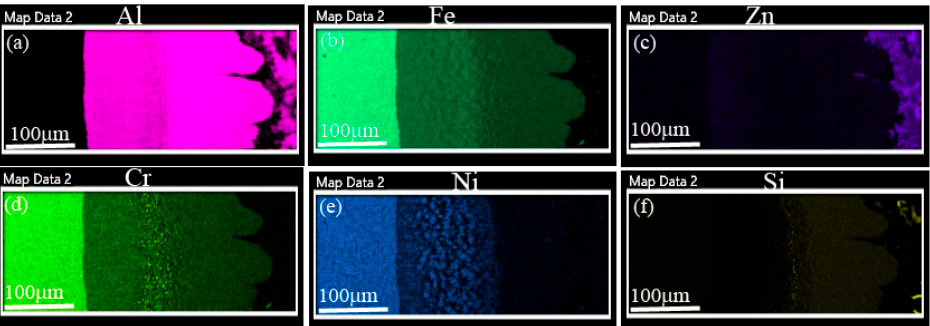
Figure 12. Elemental composition depth profiling from SS to AL-1, AL-2 and to AlZn alloy obtained using EDS technique. ( a ). SEM-SEI images, and ( b ). Elemental compositiona profile.